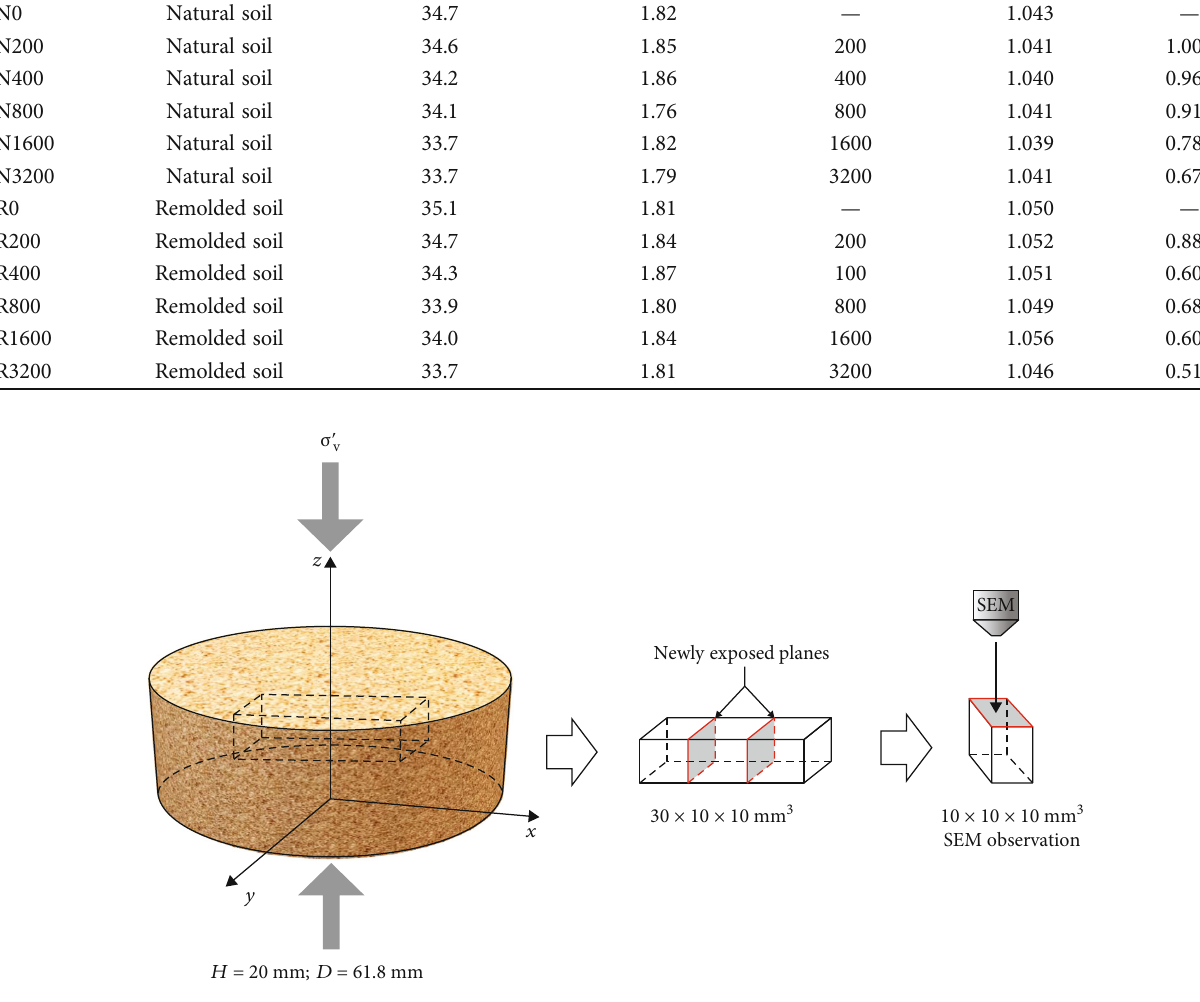
Figure 3: Subsample preparation for microscopic